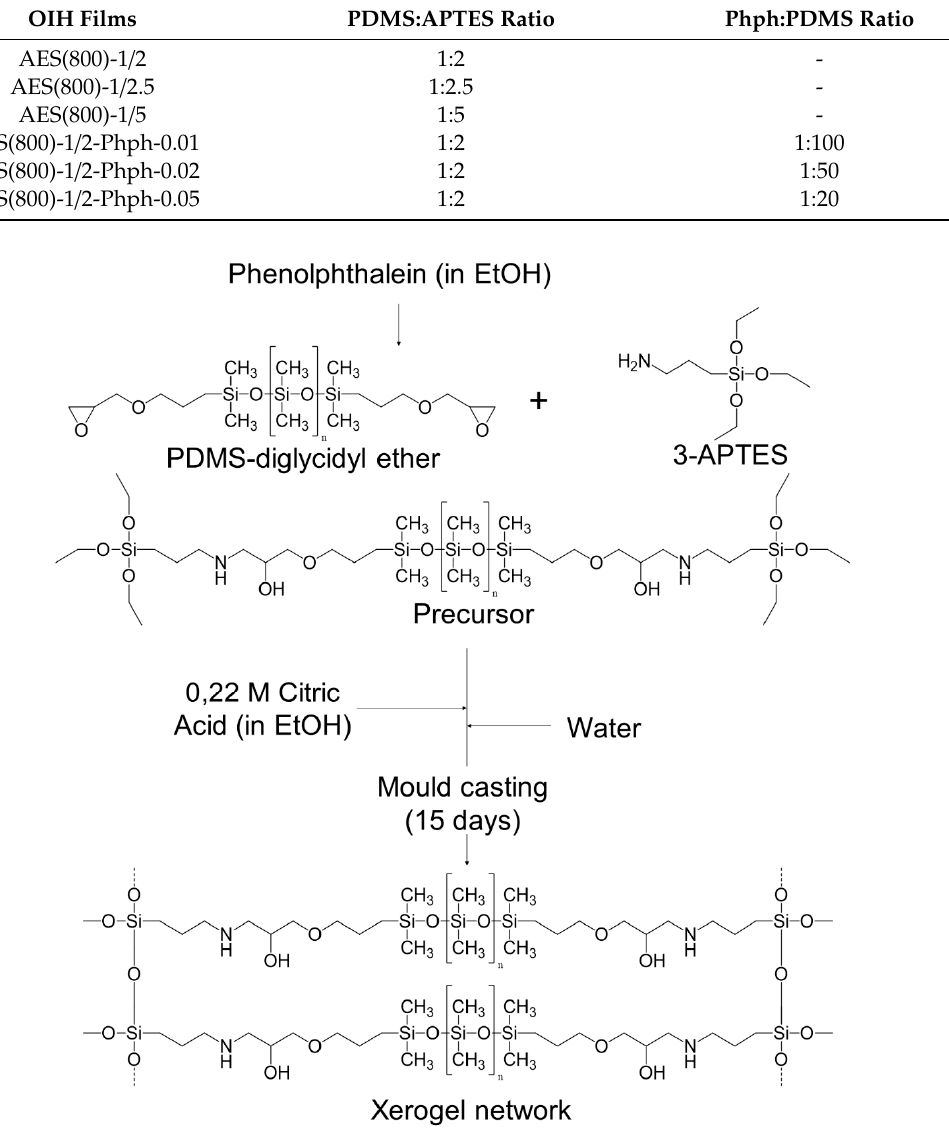
Figure 1. Schematic of the main steps used in the synthesis of PDMS based OIH films.